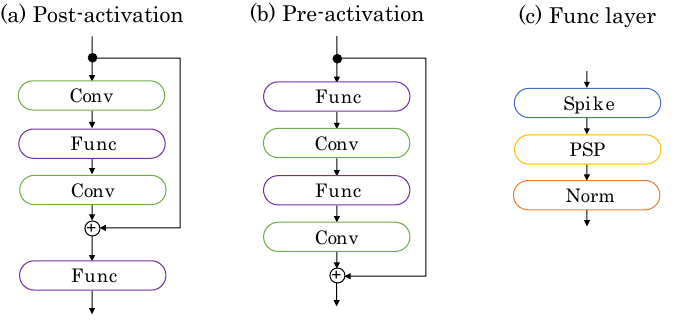
Figure 5. Network blocks. ( a ) Post-activation residual block, ( b ) Pre-activation residual block, and ( c ) Func layer. Postsynaptic potential (PSP) and Norm in the Func layer represent Equation (5) and + r ) , where r is the refractory normalization. Spike represents f s ( ·